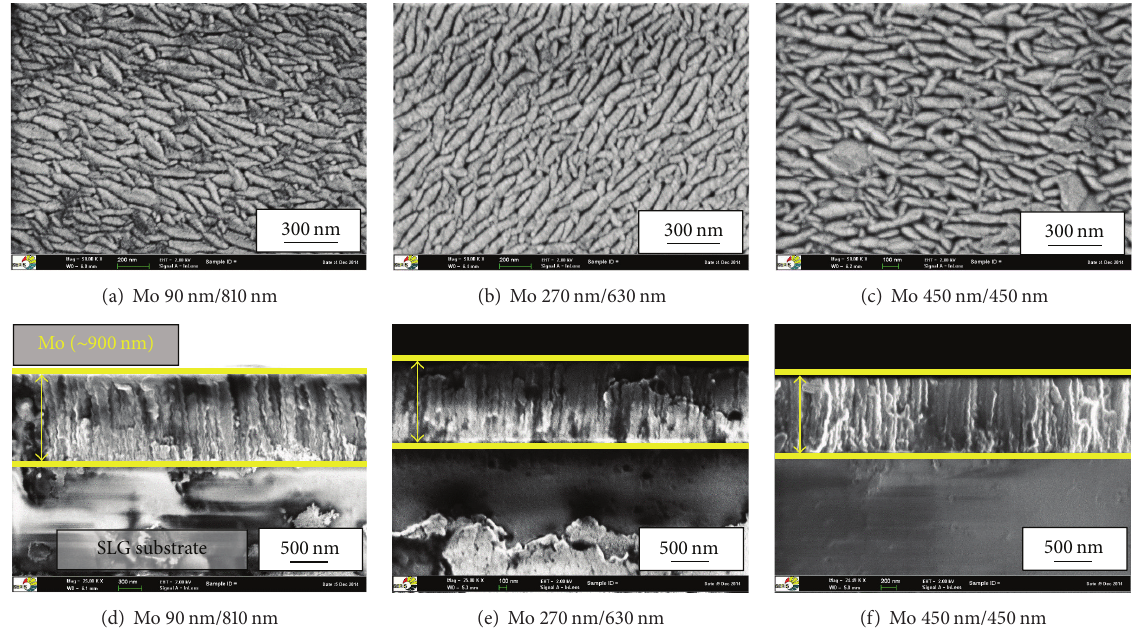
Figure 5: Surface-view and cross-sectional SEM images of bilayer Mo films with different thickness ratios of the bottom and top Mo layers: (a) 90 nm/810nm, (b) 270 nm/630nm, and (c) 450 nm/450